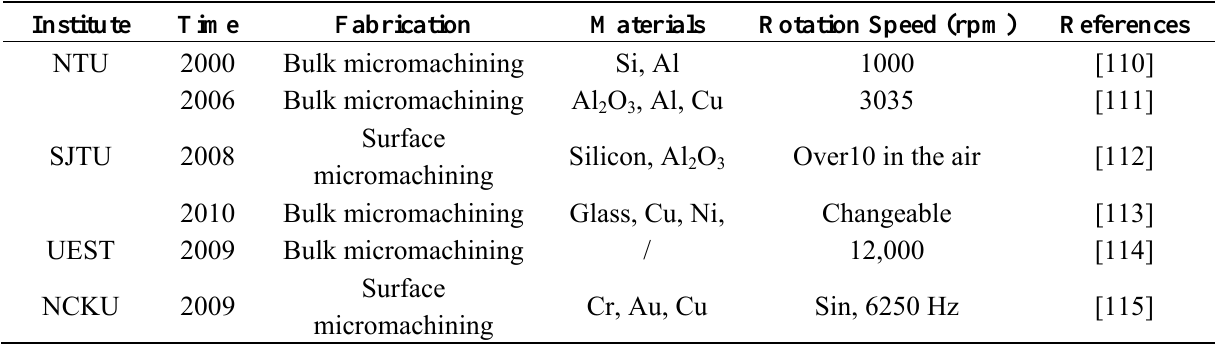
Table 10. The summary of MSG